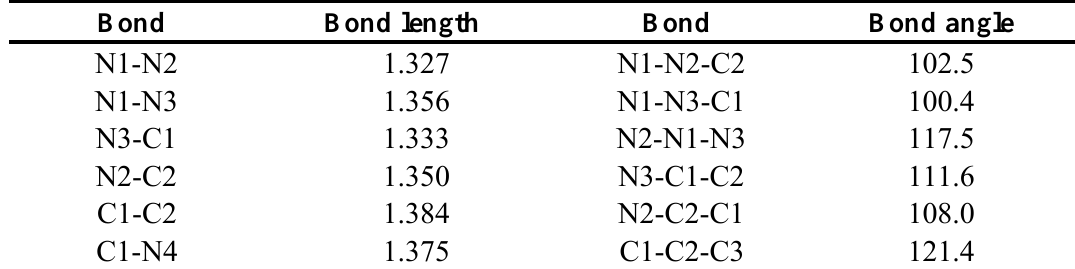
Table 1. Selected bond lengths and bond angles for 5a